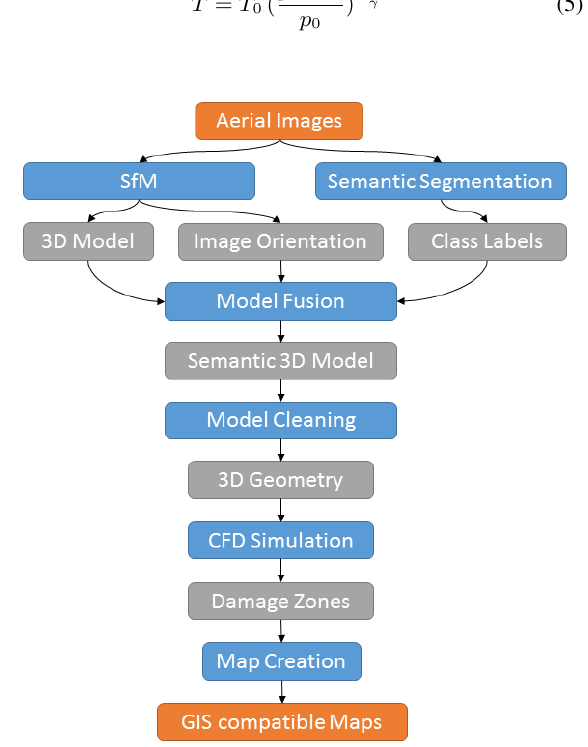
Figure 4. Schematic overview of the workflow. Orange boxes depict input and output data, grey boxes mark intermediate results and blue boxes symbolize specific modules in our